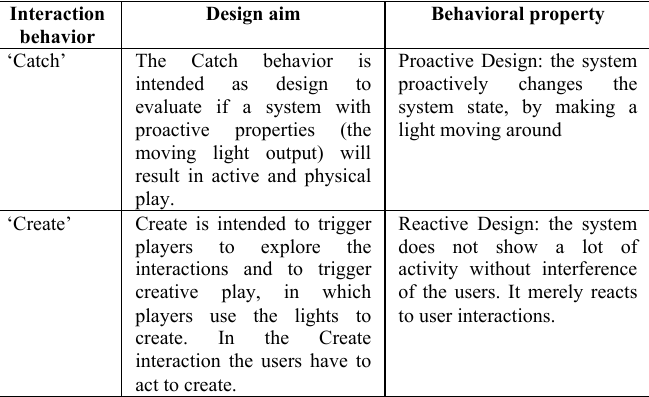
TABLE I. O VERVIEW OF TWO INTERACTION